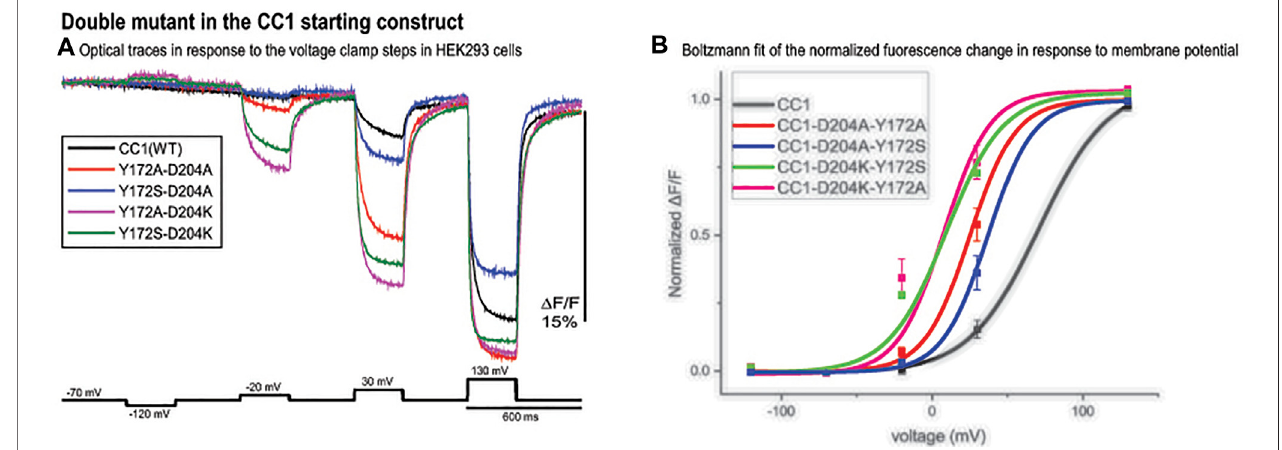
FIGURE 5 | Double mutant in the CC1 starting construct. (A) . Fluorescence response of HEK293 cells expressing CC1(WT) or CC1(WT) with double mutations in theloopstodepolarizingandhyperpolarizingvoltagesteps.Thetracesaretheaverageofthreecells(eachcellistheaverageof16trials)withouttemporal fi ltering.Images were recorded at a frame rate of 500 fps. (B) . The optical signal was normalized and fi tted to a Boltzmann equation. All double mutant combinations shifted the voltage response to more negative potentials ( n = 3 for all constructs).